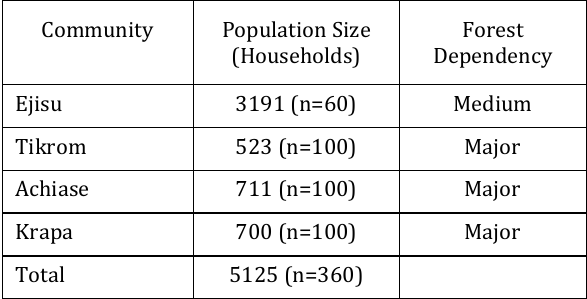
Table 1. Sample distribution over the surveyed villages